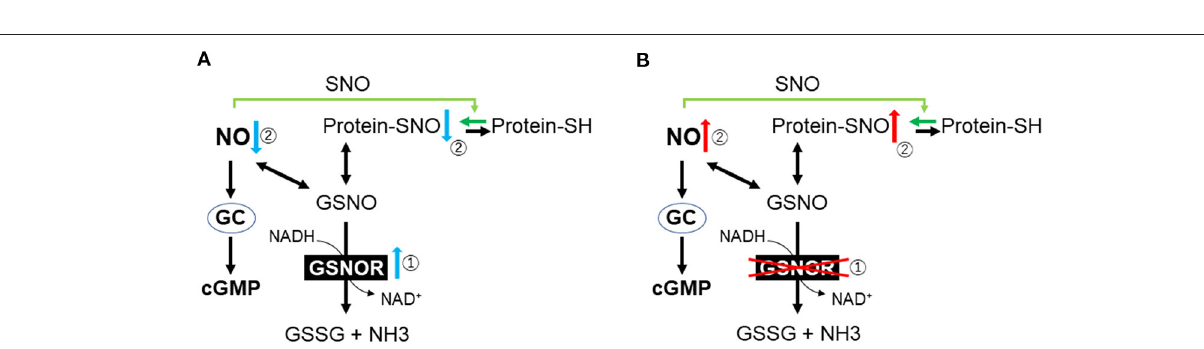
Frontiers in Medicine |